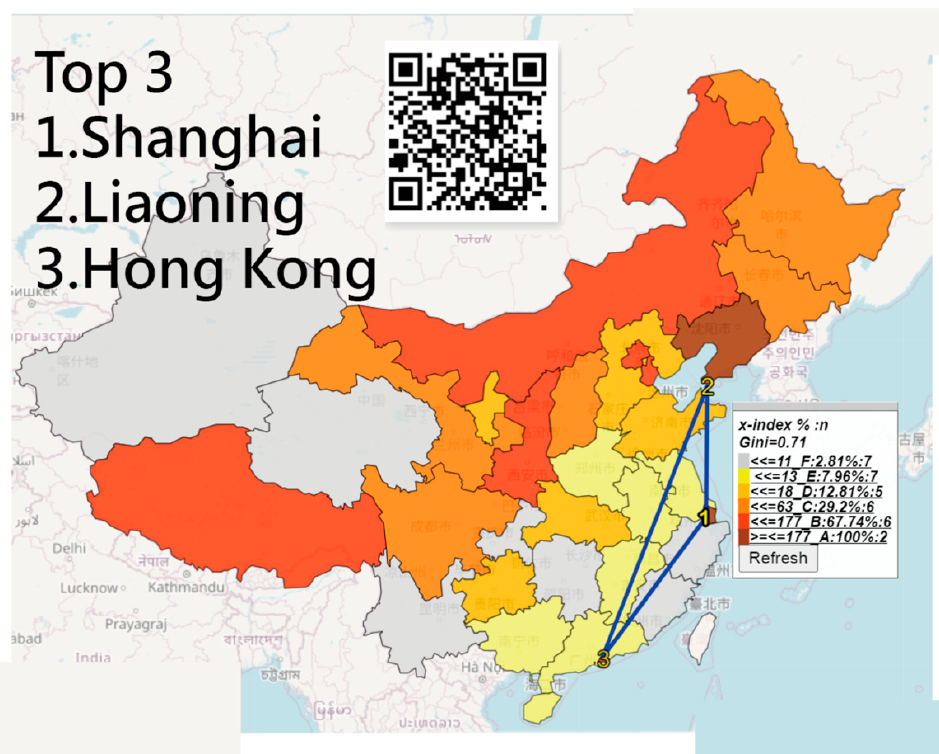
Figure 4. The top three regions with the most inflection point (IP) days in